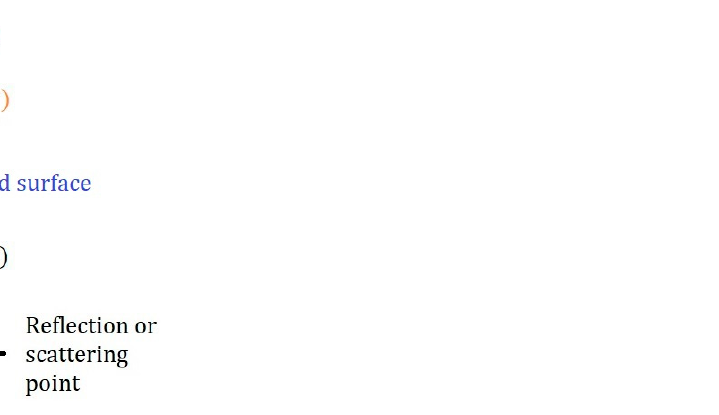
Figure 6. Optical path of light flux above and below the pond surface.